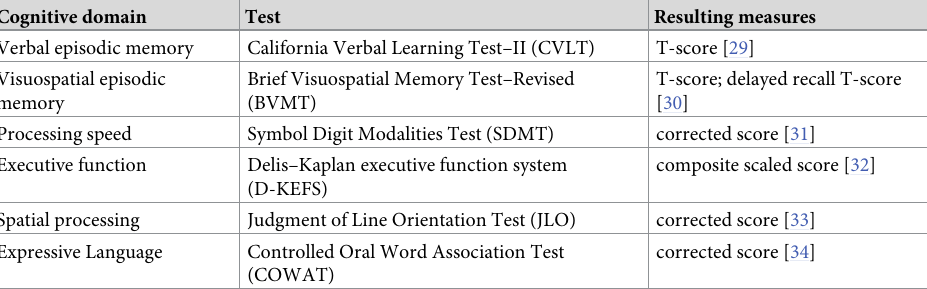
Table 1. Neuropsychological